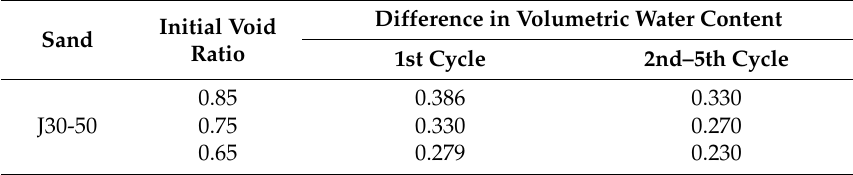
Table 4. Differences of the volumetric water content according to the initial void ratios.